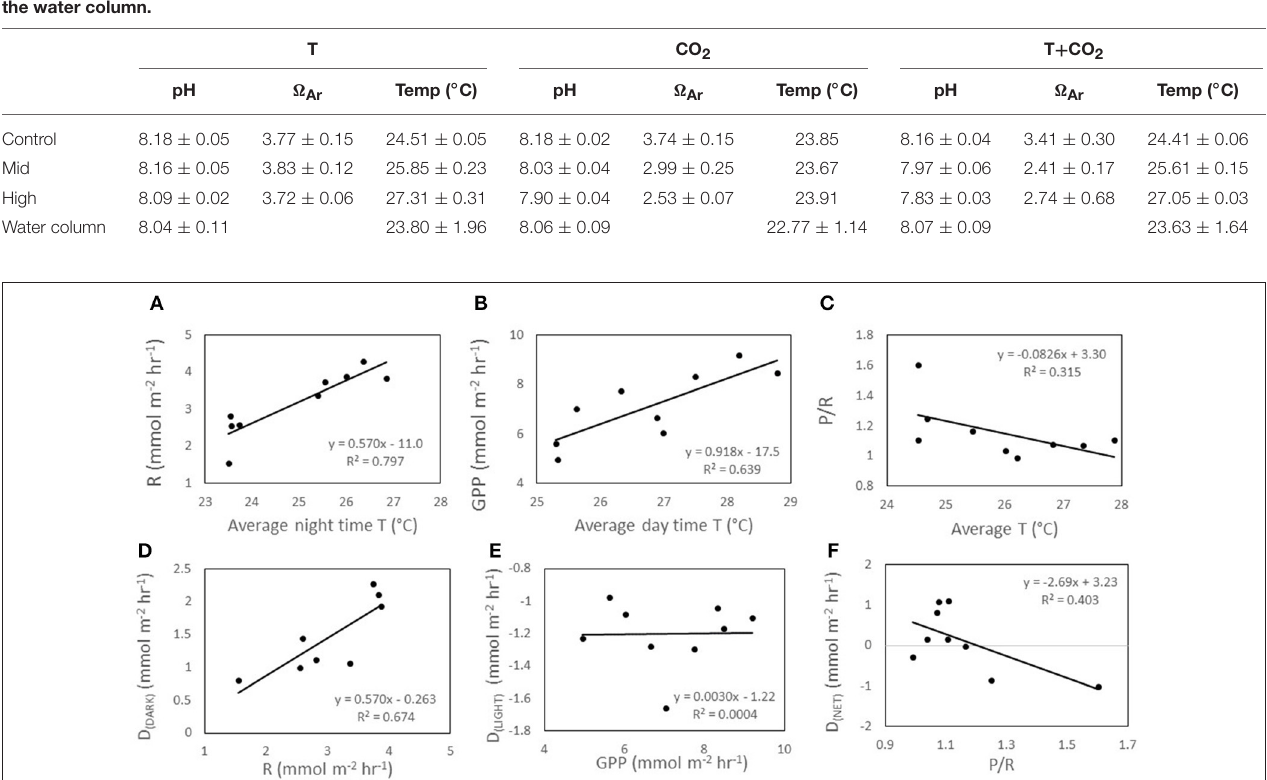
incubations (ANOVA p = 0.48), however, there was a significant difference between high CO 2 treatments and controls (ANOVA p = 0.02). 1 D NET was significantly greater in the High-T than in the High-T + CO 2 treatments ( p = 0.01). Average 1 D NET was not significantly different between Mid-T and Mid-CO 2 ( p = 0.16), than for High-CO 2 ( p =